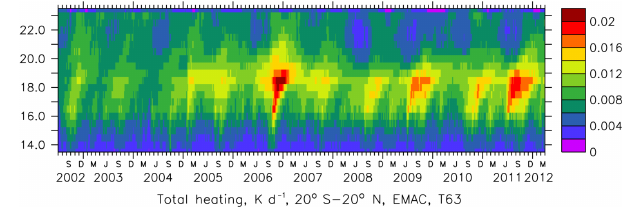
Figure 5. Simulated aerosol radiative heating in the tropics (so- lar + infrared, T63L90).